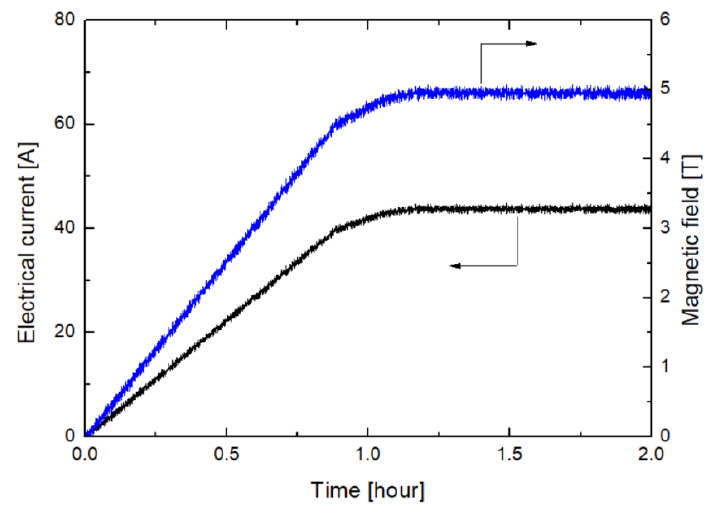
Figure 10. Magnetic field variation with respect to the supplied electrical current.